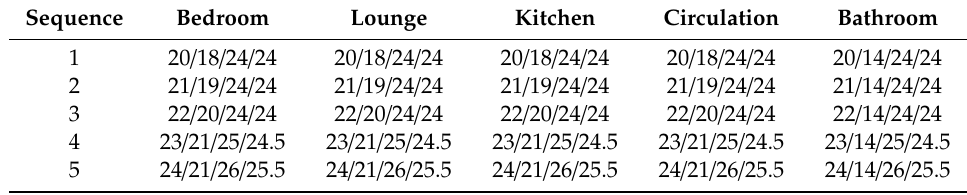
Sequence definition for both buildings: heating setpoint (HSP; ◦ C) / heating setback (HSB; ◦ C) / natural ventilation setpoint (NVSP; ◦ C) / shading control temperature (SCT; ◦